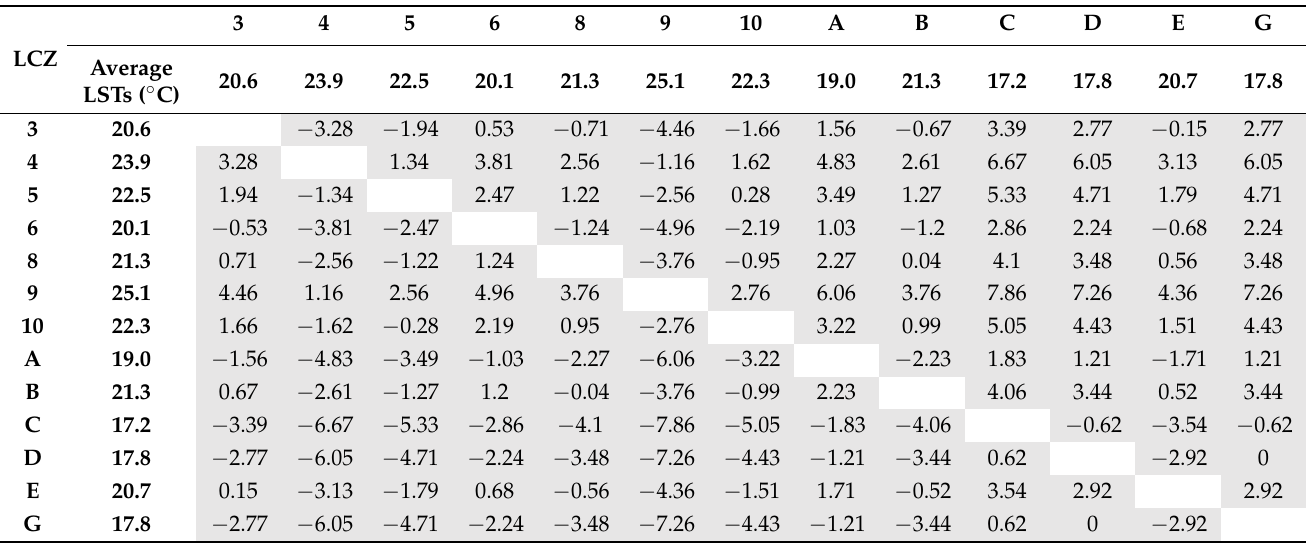
Table 4. Temperature differences between LCZs necessary for calculation and mapping of SUHI